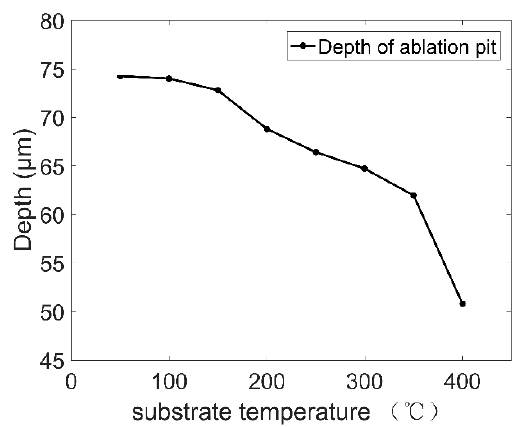
Figure 6. Relationship between ablation depth and substrate temperature.